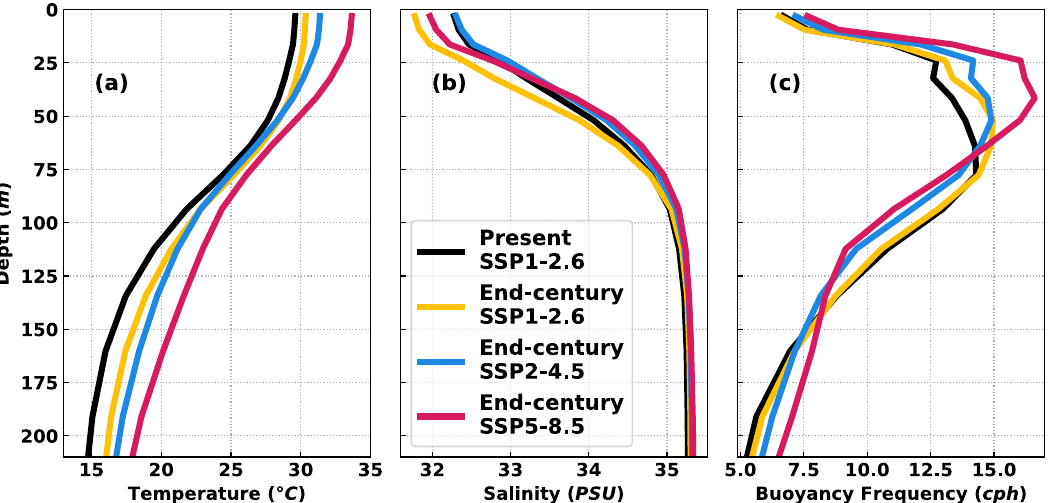
Fig. 5 Initial pro fi les used in numerical model simulations. Mean pro fi les of ( a ) temperature, b salinity and ( c ) buoyancy frequency used for model initialisation in four experiments to study the differences in IT generation, propagation, and dissipation between the present (2015 – 2024) and end-century (2091 –